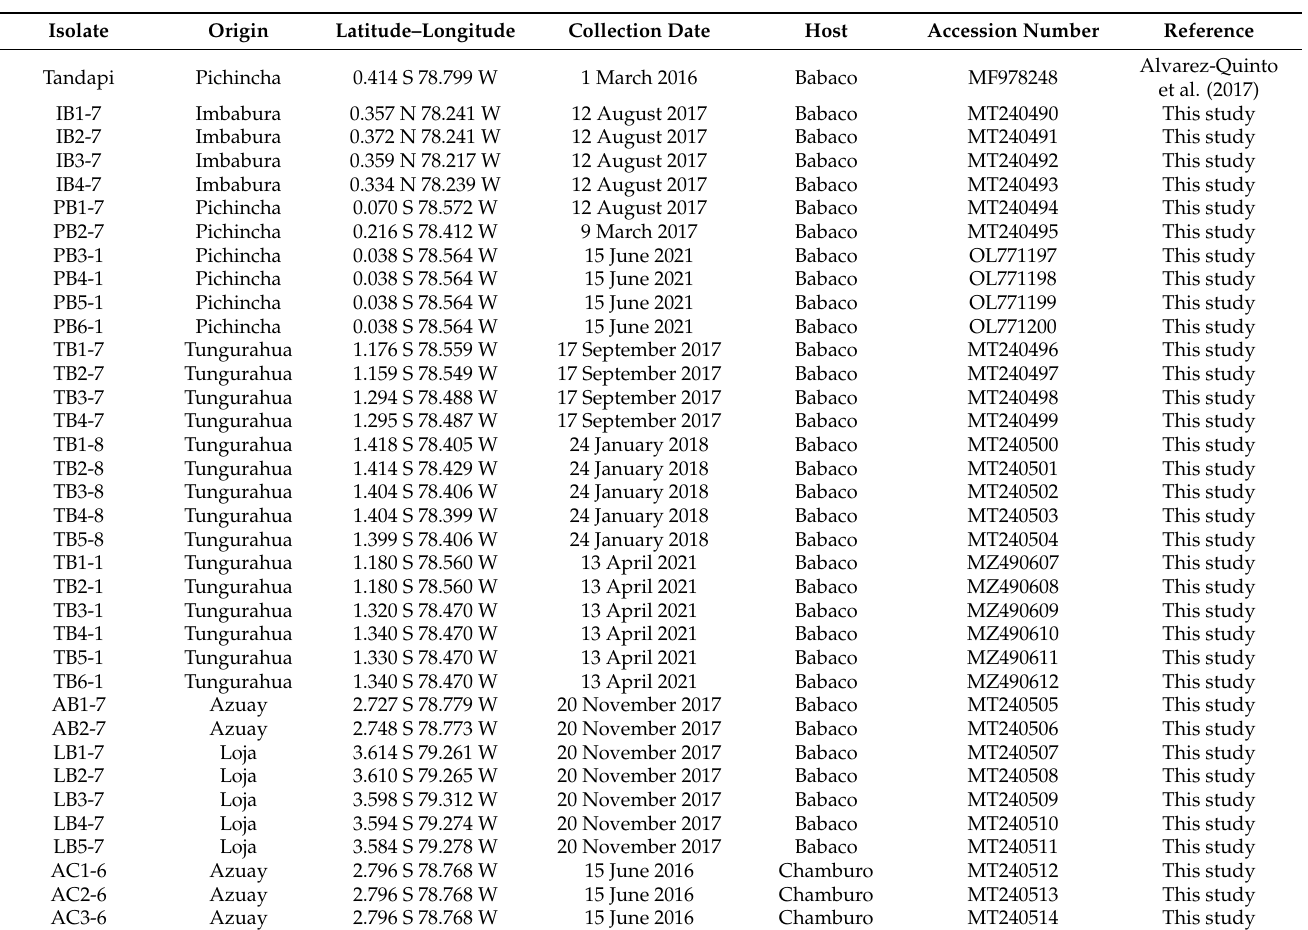
Figure 6. Babaco leaves showing symptoms of chlorosis, mottling, and mosaic, in greenhouse cultivars, Loja, Ecuador. ( A ) Babaco plants. ( B ) A close-up view of a leaf. Table 3. Babaco mosaic virus isolates used in this study.